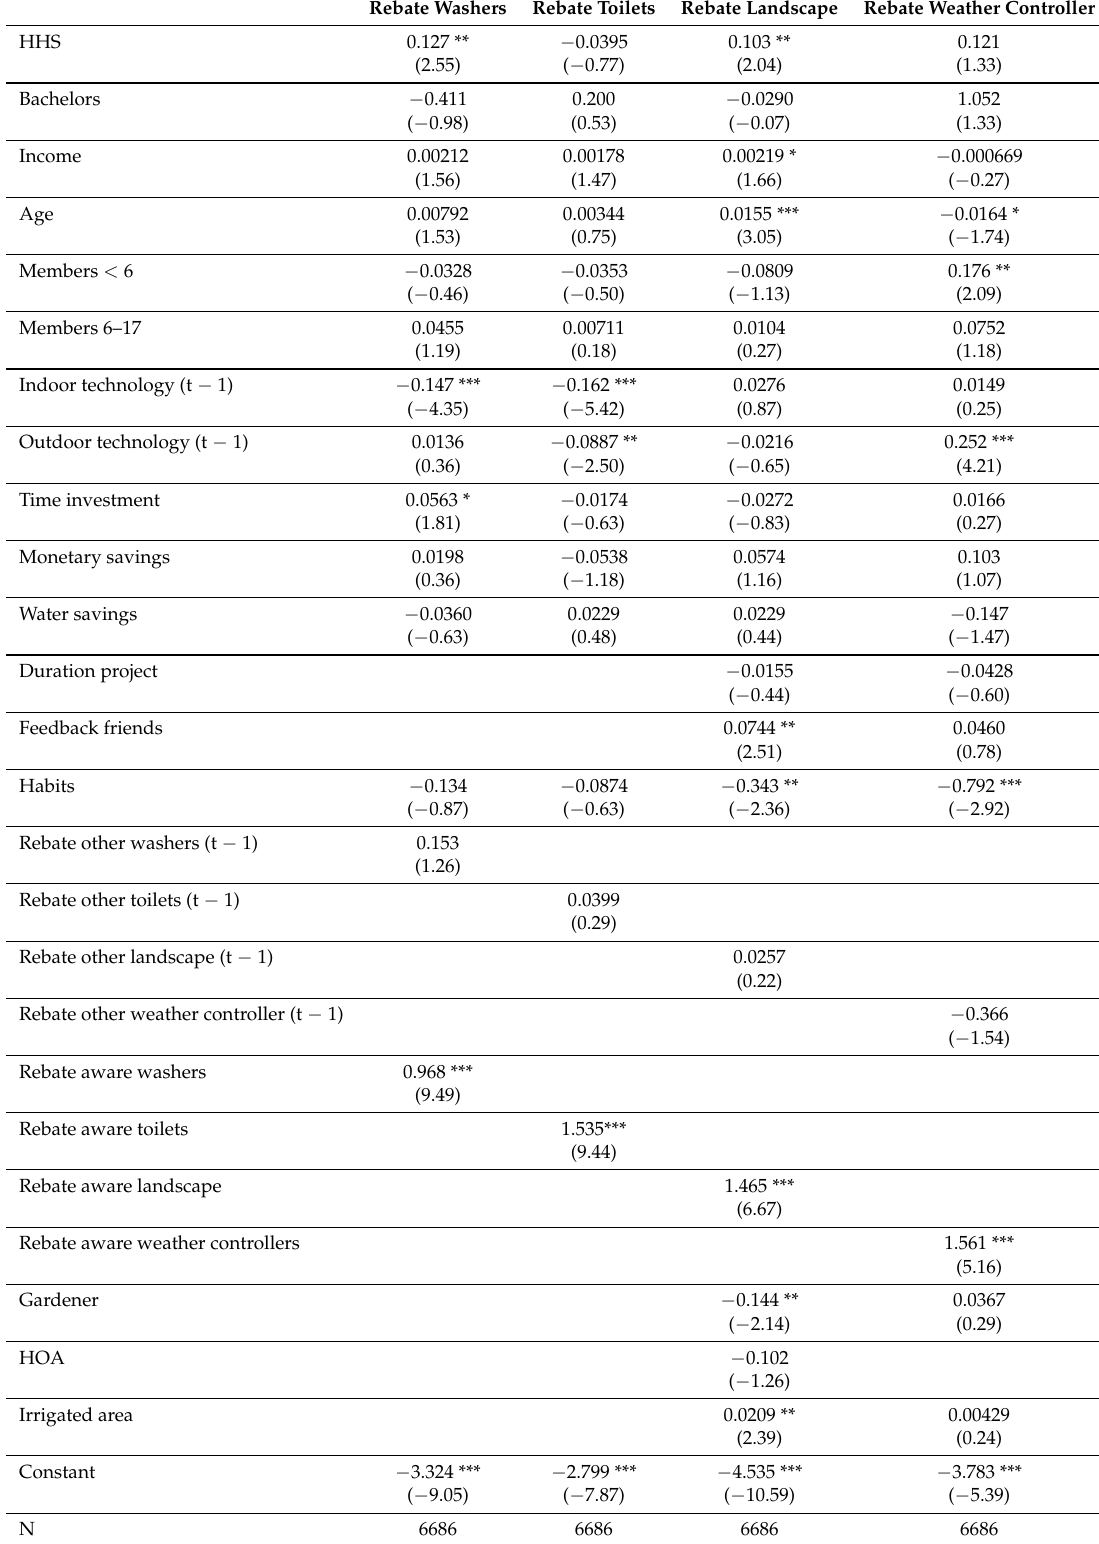
Table 4. Estimation results for the probability of receiving a